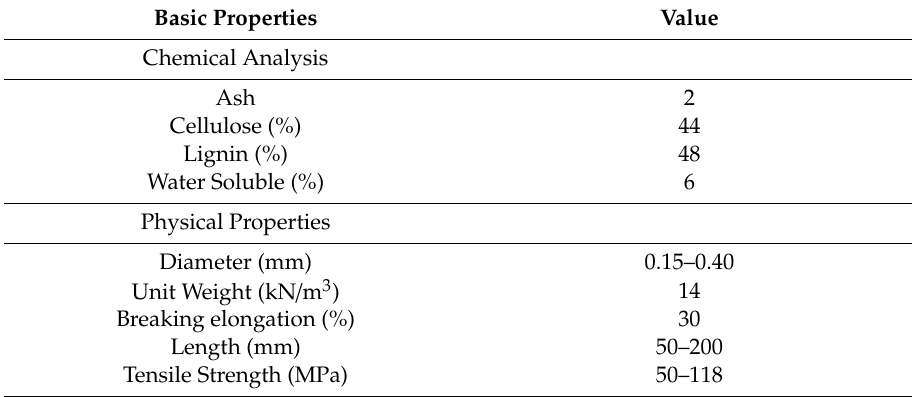
Table 3. Chemical and physical analysis of coir fiber.